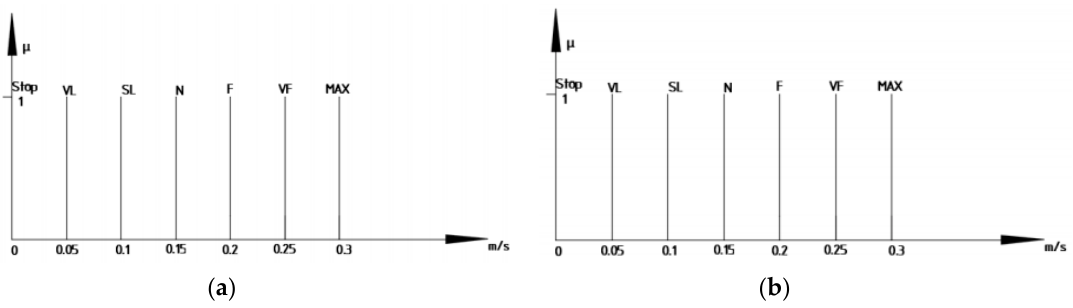
Electronics 2019 , 8 , 200 Figure 18. Input membership functions: ( a ) load, and ( b ) tracking error. Figure 18. Input membership functions: ( a ) load, and ( b ) tracking error.